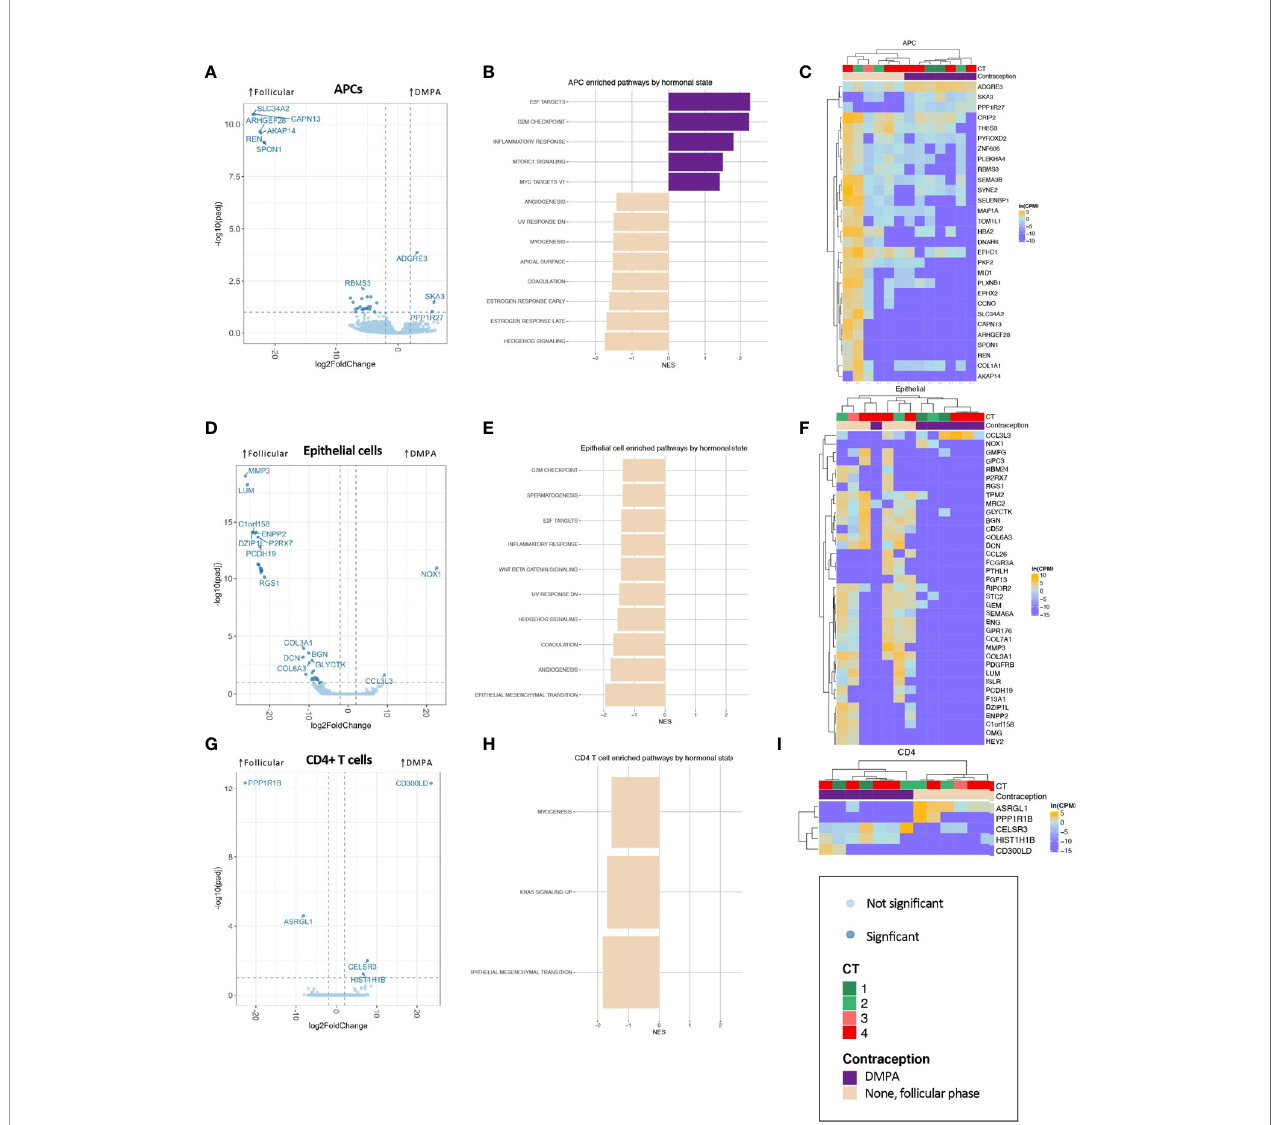
FIGURE 3 | Association of DMPA with FGT APC (A – C) , epithelial cell (D – F) , and CD4+ T cell (G – I) transcriptional landscape. (A, D, G) Volcano plots showing differentially expressed genes, with signi fi cantly differentially expressed genes (BH-corrected p-value of 0.1) shown in darker points. (B, E, H) Signi fi cantly enriched gene sets through GSEA based on the Hallmark gene set with an FDR-corrected q-value <0.1. (C, F, I) Signi fi cantly differentially expressed genes are shown in heatmaps, with clustering based on Spearman